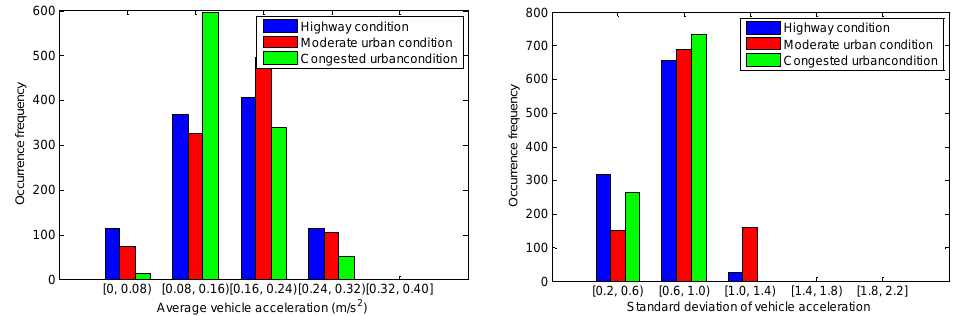
Figure 10. Comparison histograms of part characteristic parameters.